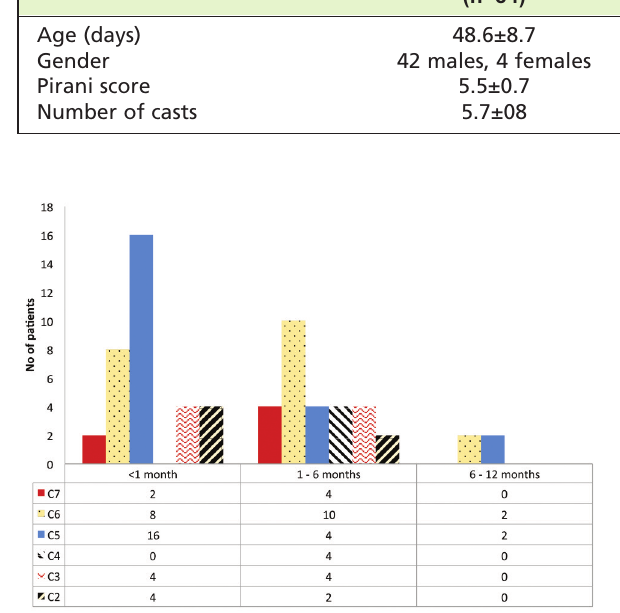
Pirani score versus number of casts required, C represents Fig. 2: number of casts.